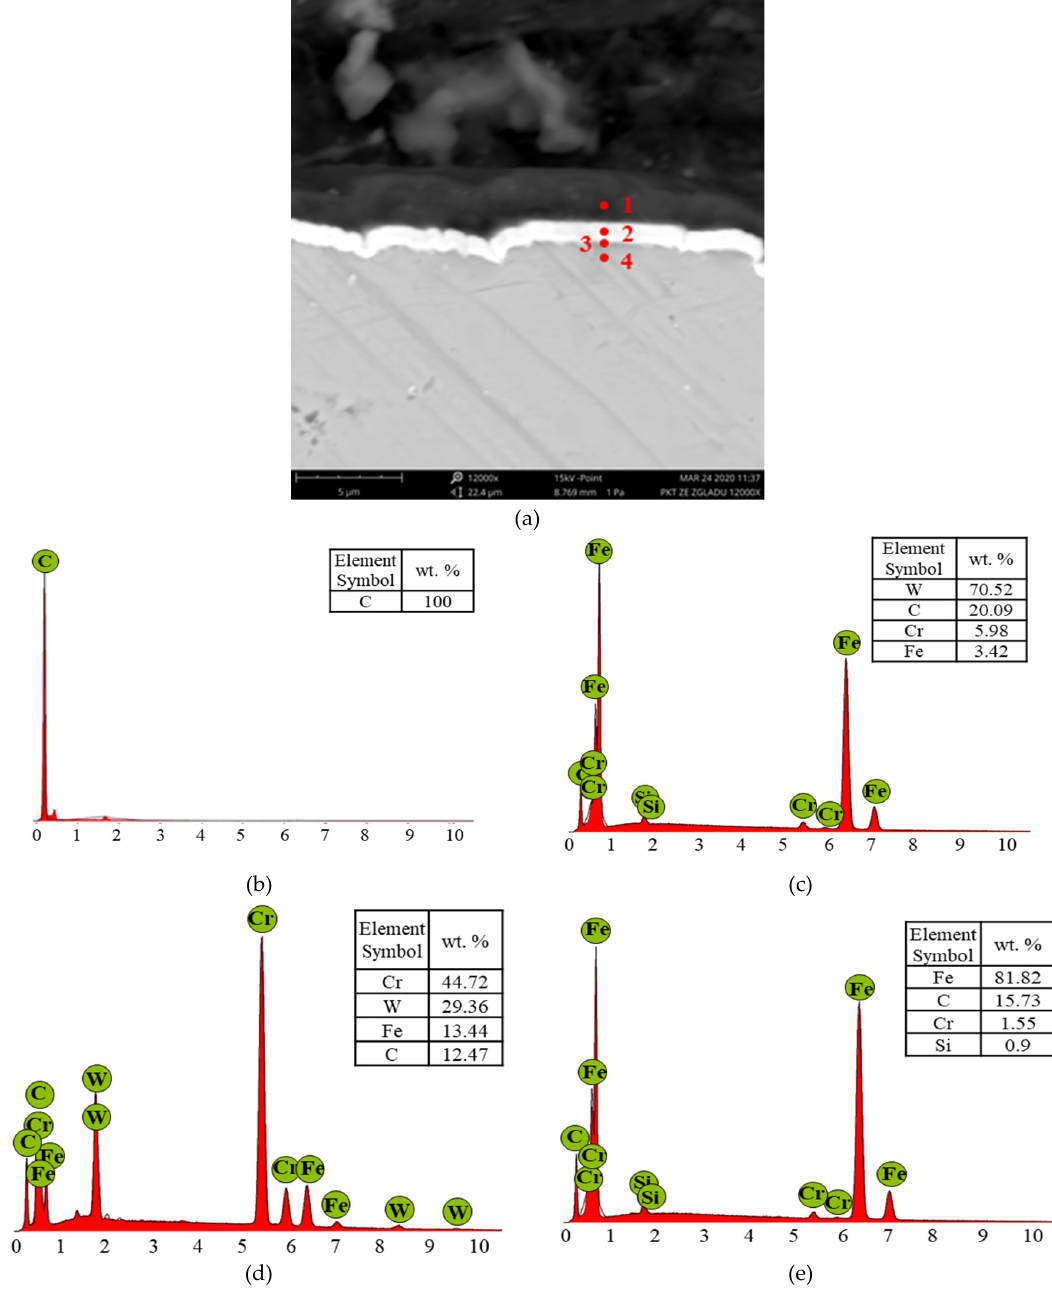
Figure 3. ( a ) A cross-sectional view of the disc structure with EDS patterns at four different points: ( b )—the coating, ( c ) and ( d )—the intermediate layer, ( e )—the substrate.